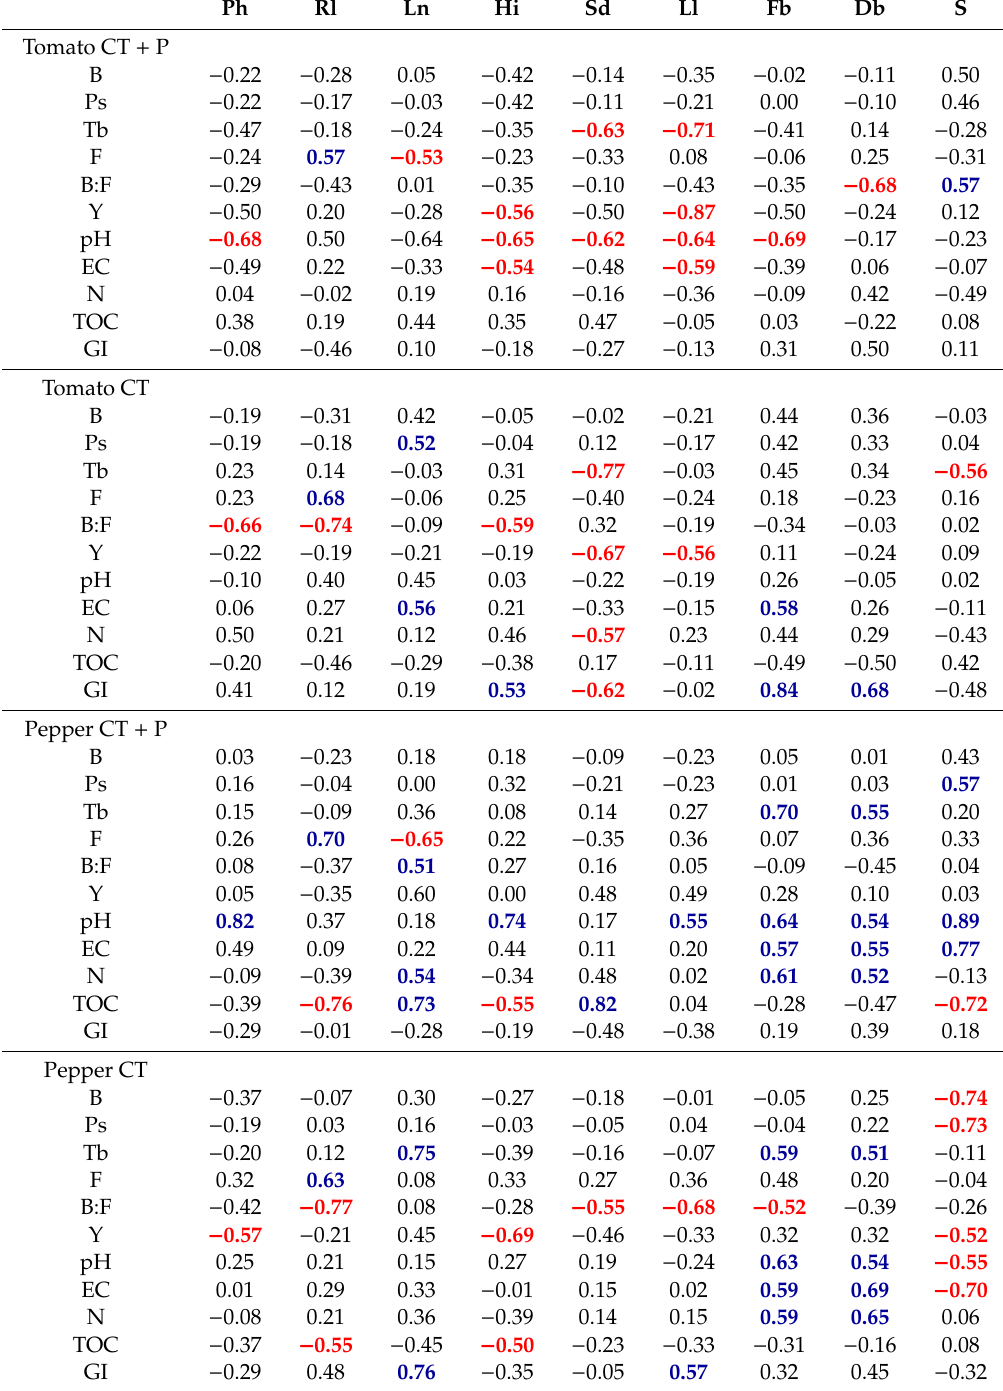
Table 7. Relationship between CT characteristics, including total bacteria (B), pseudomonads (Ps), thermophilic bacteria (Tb), fungi (F), bacteria: fungi ratio (B:F), yeast (Y), pH, electric conductivity (EC), total nitrogen (N), total organic carbon (TOC), germination index (GI) and assessments of plant height (Ph), root length (Rl), leaves number (Ln), height 1 st internode (Hi), stem diameter (Sd), length 1st leaf (Ll), fresh biomass (Fb), dry biomass (Db), and SPAD (S) on tomato, pepper and melon plants under CT + P and CT treatments showed by Pearson’s coe ffi cients as resulted from the regression analysis; | values | > 0.50 are showed in bold, colored in blue or red if they are positively or negatively correlated,